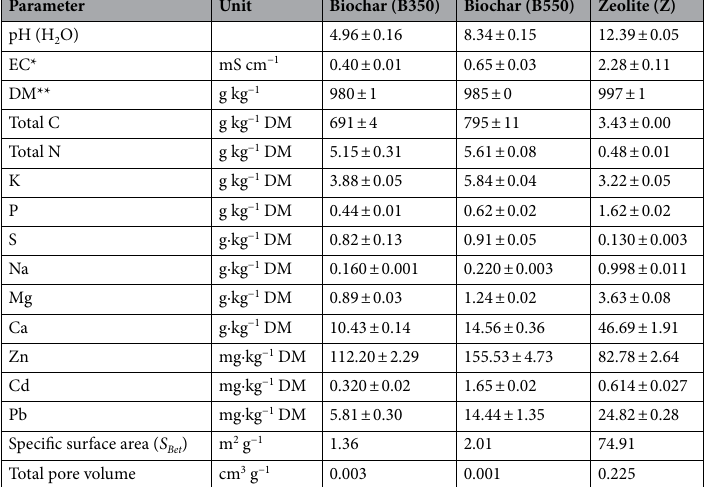
Table 2. Chemical properties of amendments used in the experiment (means ± standard deviation). *EC-electrical conductivity; **DM-dry matter.